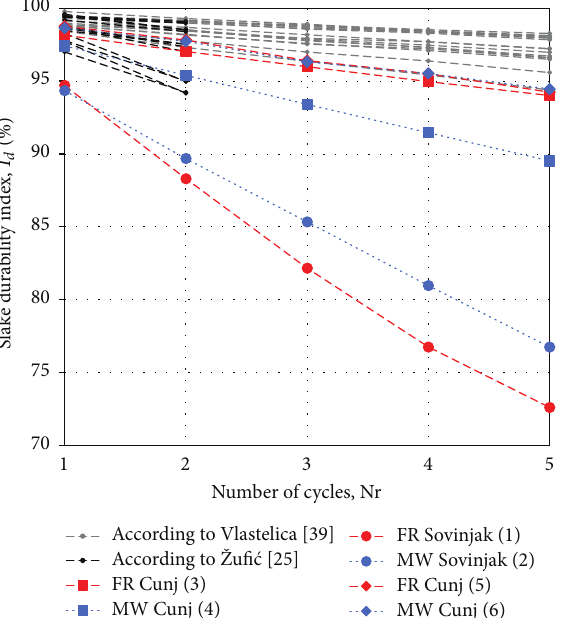
Figure 10: Influence of the number of slaking cycles on the slake durability index of the siltstone samples of different weathering grades that were tested in this study and from previous tests of similar samples of fresh siltstone from a flysch rock mass in Istria [25] and marl samples from a flysch rock mass in Dalmatia [39].